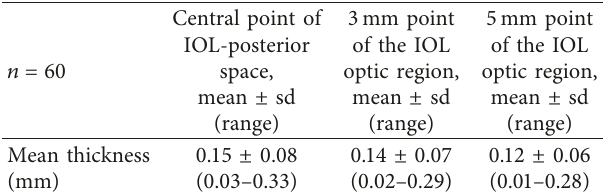
Table 2: PCO thickness measured with RTVue-100